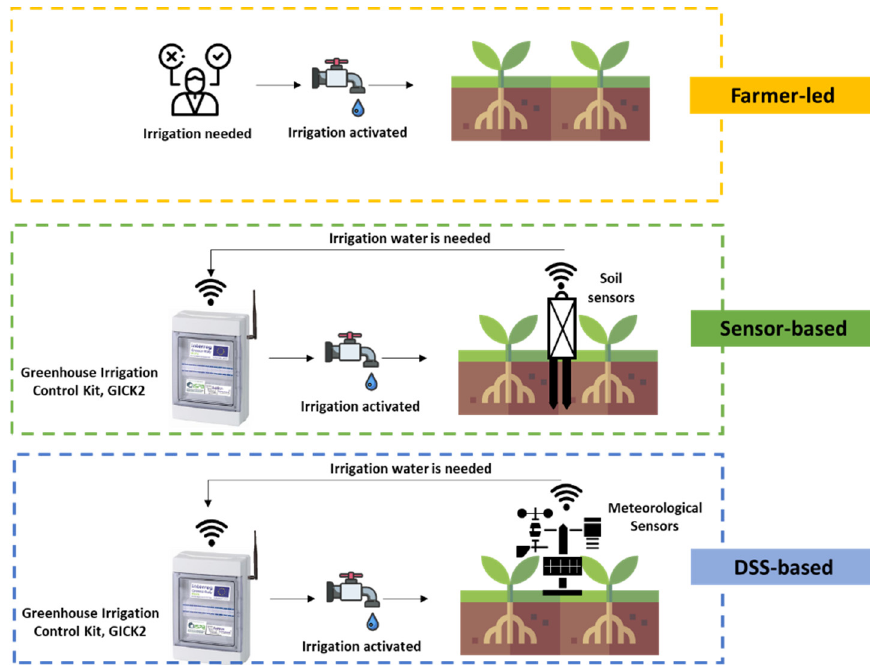
Figure 1. The layout of irrigation strategies compared for ucchini cultivation.